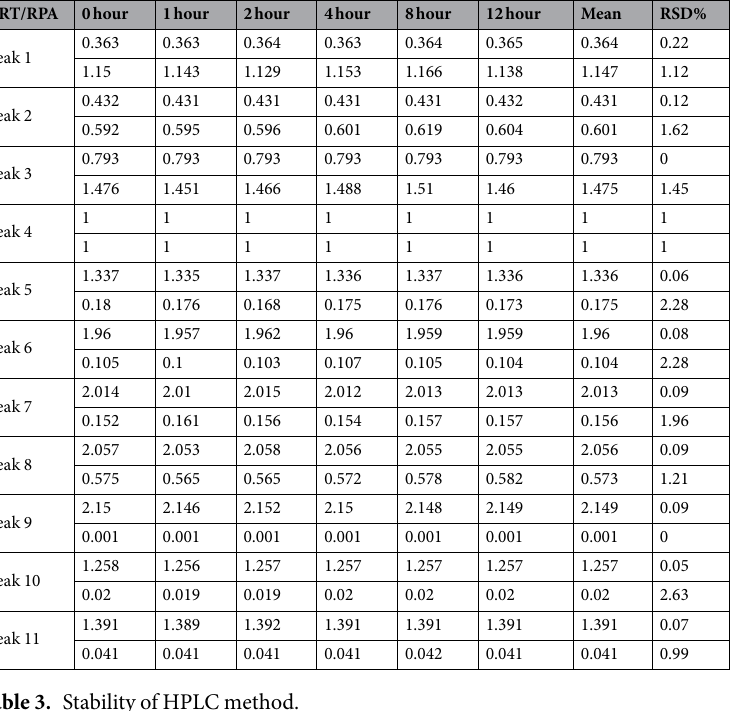
Table 3. Stability of HPLC